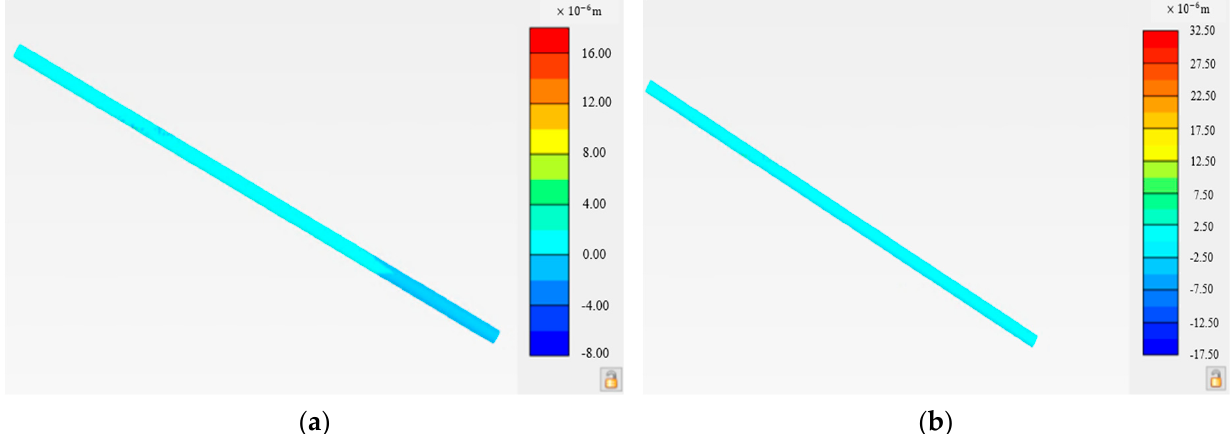
Figure 16. Displacement of east exhaust inclined shaft. ( a ) Horizontal displacement of east exhaust inclined shaft; ( b ) vertical